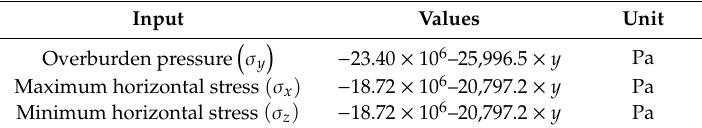
Table 9. Initial stress